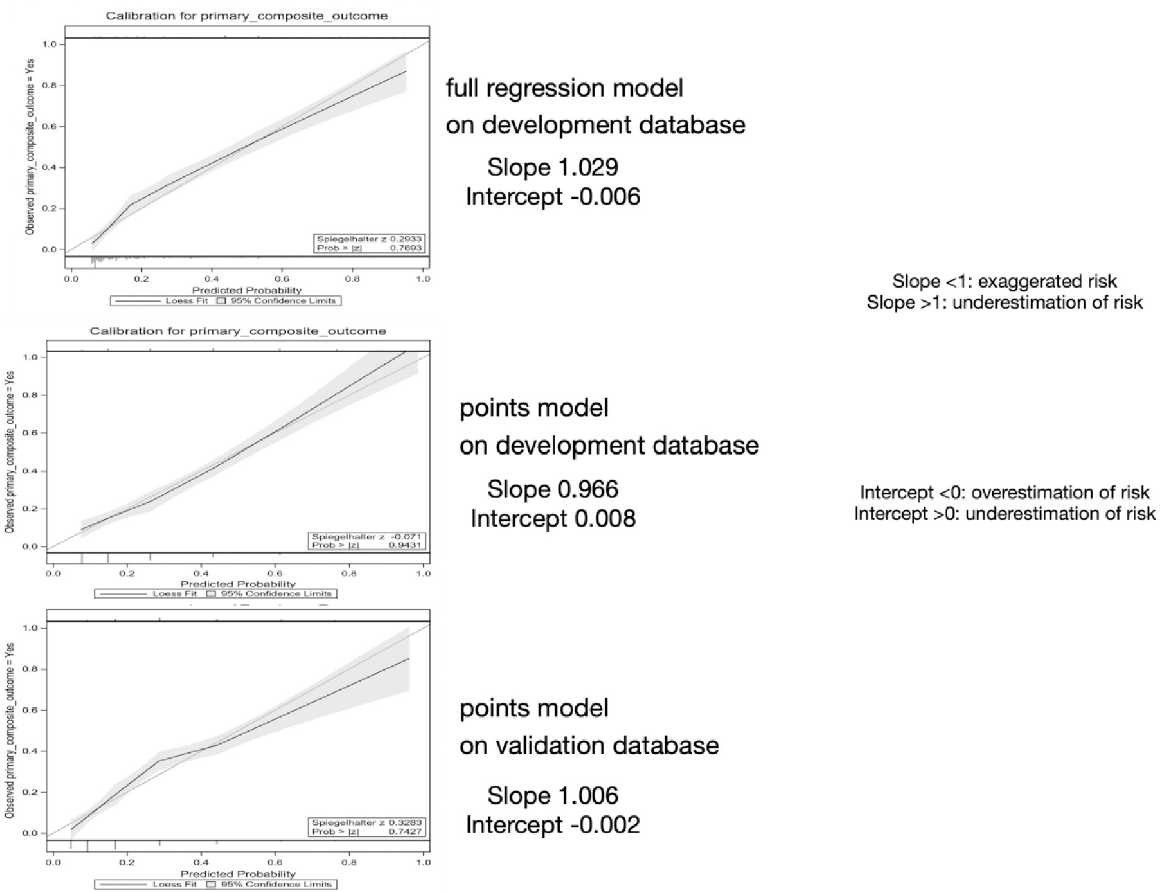
Fig 4. Calibration curves of logistic regression on development and PE-SCORE model on both